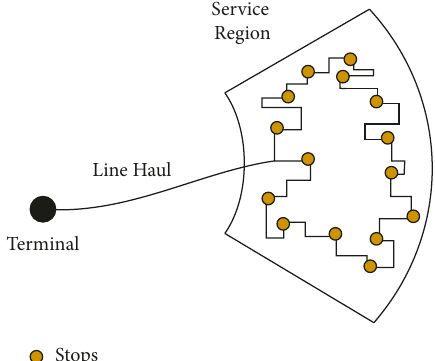
Figure 1: Route of the vehicle in a service region.